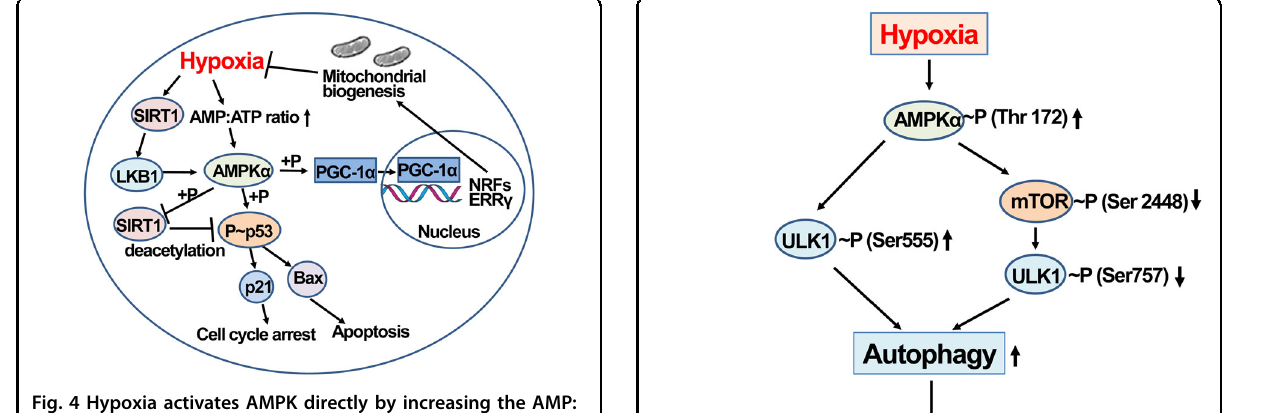
Fig. 4 Hypoxia activates AMPK directly by increasing the AMP: ATP ratio or indirectly via SIRT1 activation. LKB1 is activated by SIRT1 and promotes the phosphorylation and activation of the catalytic α -subunit of AMPK. Activated AMPK further facilitates the phosphorylation and activation of p53, which induces the upregulation of p21 and Bax, resulting in cell cycle arrest and apoptosis. Moreover, AMPK induces the phosphorylation and inactivation of SIRT1, which induces the acetylation of p53. Activated AMPK increases the phosphorylation and activity of PGC-1 α in the nucleus, triggering the transcription of mitochondrial genes, such as NRF1 and ERR γ , and enhancing mitochondrial biogenesis